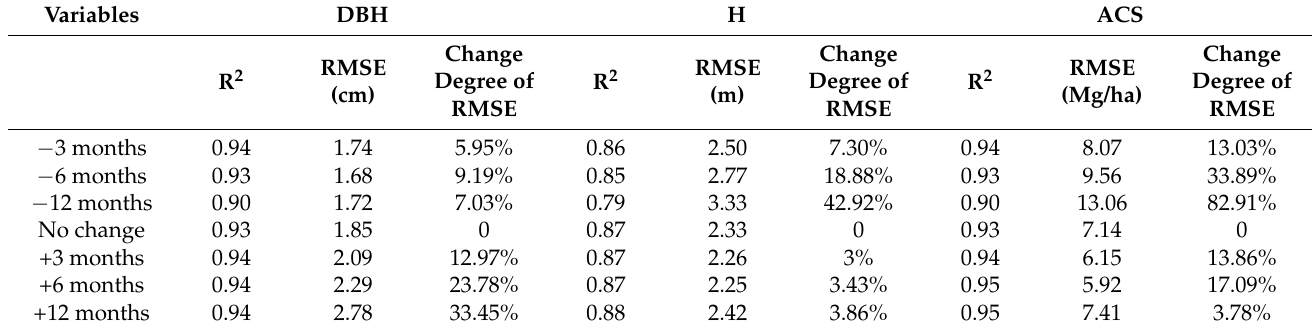
Table 3. Comparison of model predictions of the diameter at breast height (DBH), height (H), and aboveground carbon stocks (ACS) with observations of DBH, H, and ACS under different adjusted forest ages based at SP